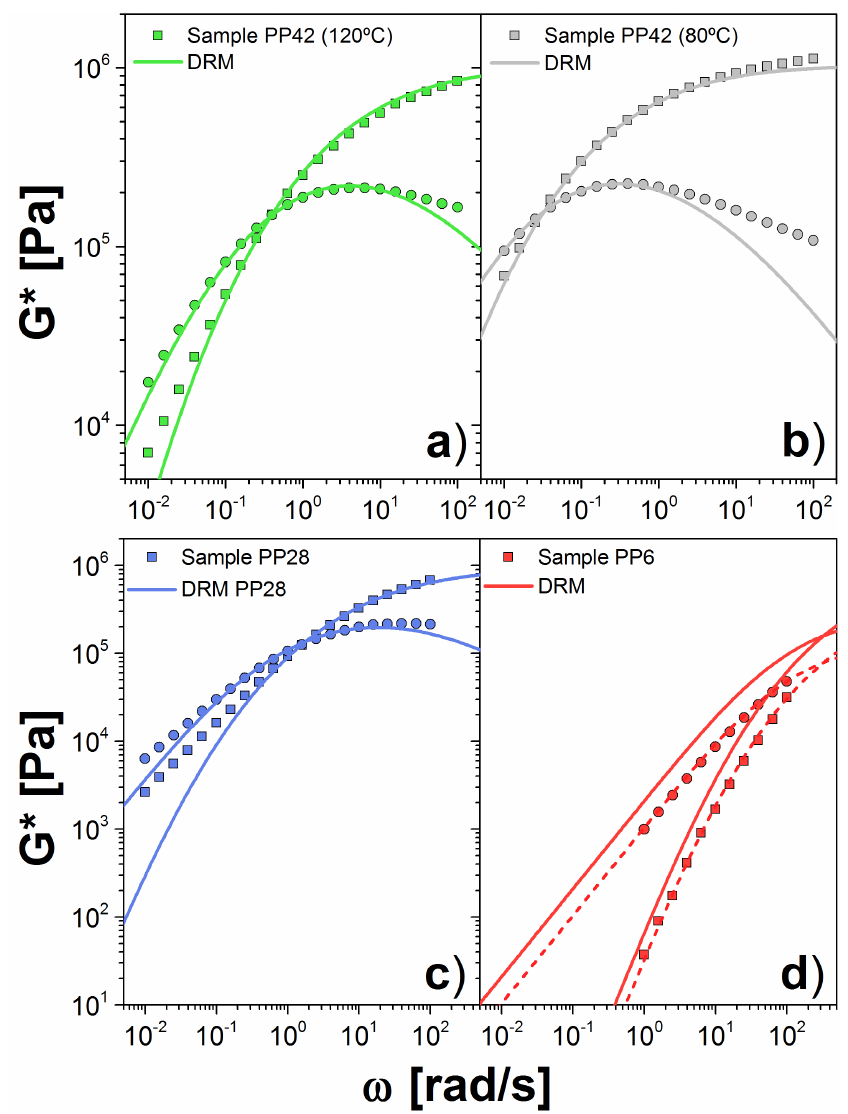
Figure 5. Dynamic moduli for PP samples PP42 at: ( a ) 120 ◦ C; and ( b ) 180 ◦ C; and for: ( c ) PP28; and ( d ) PP6 at 120 ◦ C. Symbols are the experimental data (squares = G (cid:48) , circles = G (cid:48)(cid:48) ) and solid lines are the theoretical prediction using the DRM. In ( d ), we include the calculation using the G 0 for the PP42 sample (solid line) and PP6 sample (dashed